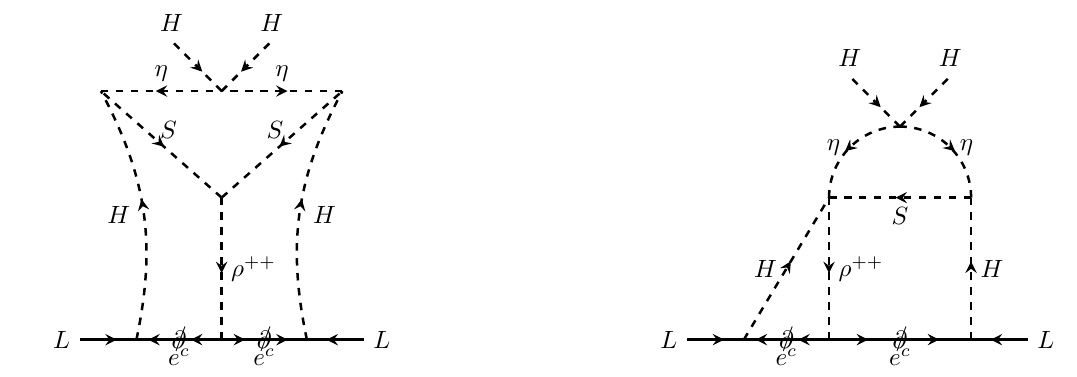
Figure 18 . Dimension 5 mass diagrams in the gauge basis. Note that given the chirality, the corresponding integral has two momenta in the numerator. This is denoted with =@ . When referring to these diagrams we will use the notation I (5) with i = 1 ; 2 following the order of the (cid:12)gures. i